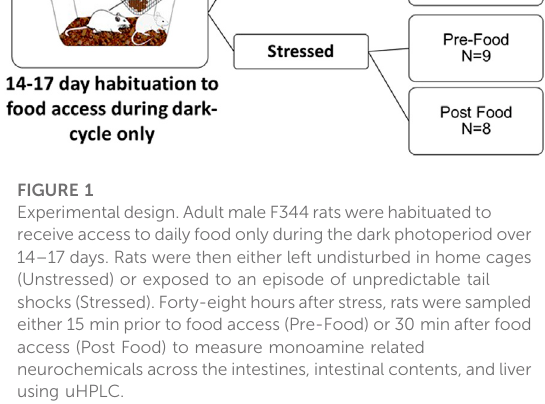
permanent marker on the base of the tails. Room temperature (21 ° C ± 1 ° C) and photoperiod (12:12 light/dark) were controlled